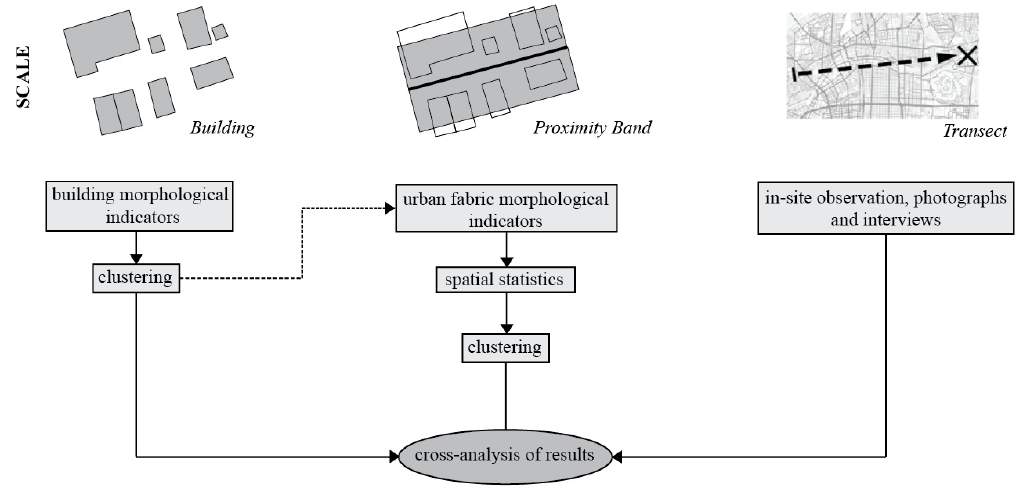
Figure 3. Presentation of the methodological protocols.